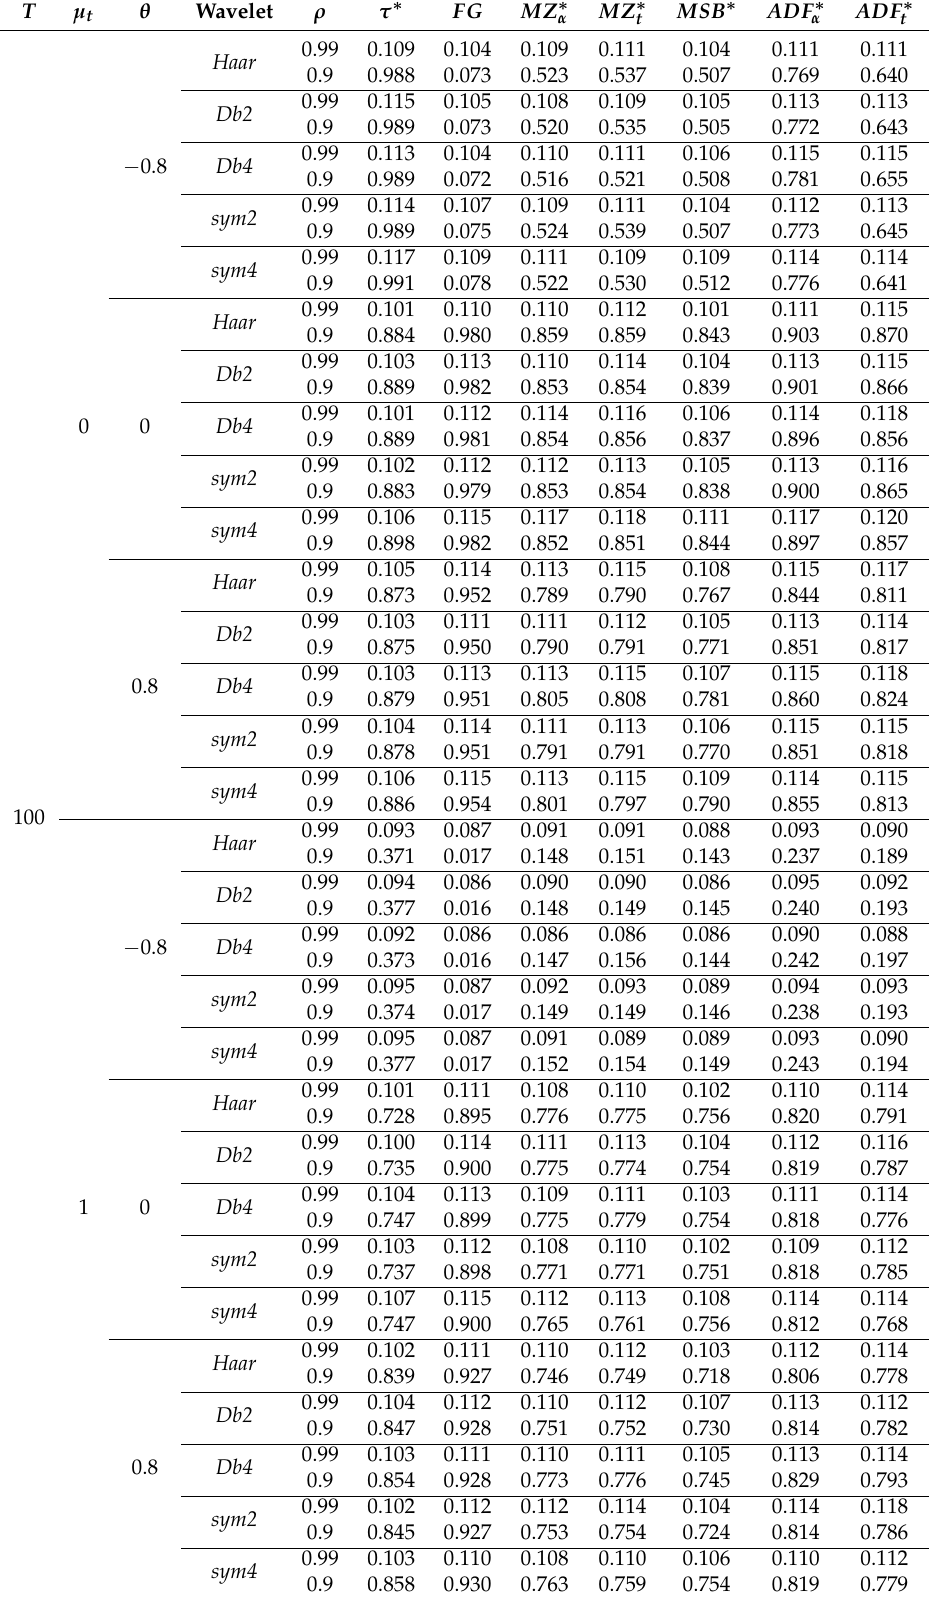
Table 6. The size-adjusted power of wavelet based